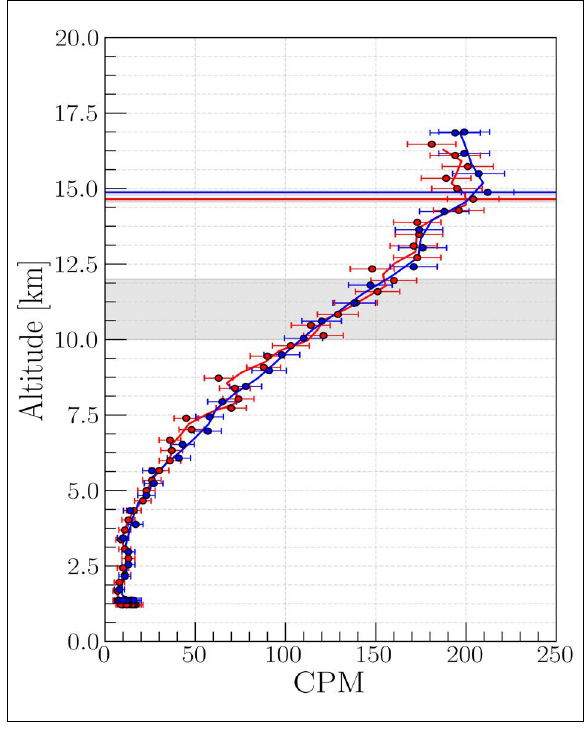
Figure 8: The counts per minute (CPM) profile of the balloon flight shown as a function of altitude. Red represents ascent, while blue represents descent. The grey shaded area between 10 km and 12 km represents the expected count rate measurement at the aircraft cruising altitude, while the horizontal lines at about 14.9 km and 14.7 km show the count rate measurements at the RP- max before and after burst